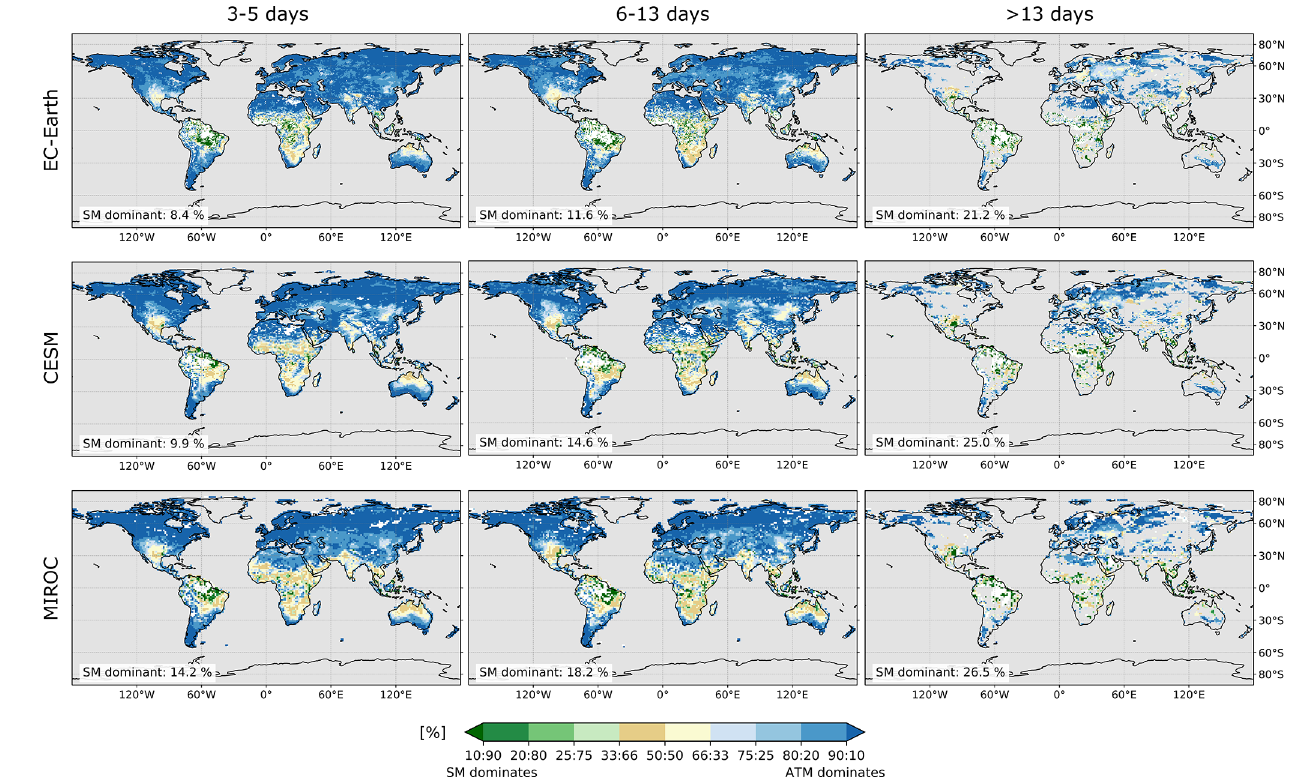
Figure 8. Contribution of atmospheric circulation (ATM) vs. soil moisture (SM) to warm spells during the local summer season when daily mean temperature anomalies exceed 1.5SD (standard deviation) from the ERA-Interim 1981–2010 climatology. The local summer season is defined as the hottest consecutive 3 months (from ERA-Interim) for each grid point. The two approaches to compute the SM vs. ATM contribution are merged, giving equal weight to both. Events are categorized into spells lasting 3–5d, 6–13d, and 14d or longer. Ocean grid points, Antarctica, Greenland, and Iceland are masked out in grey using the Greenland–Iceland (GIC) region from the AR6 reference regions for the latter two. Grid points for which no events were identified are also masked out in grey. Grid points for which the contributions could not be determined (see text) are masked out in white. In the lower left corner the grid points for which the SM contribution dominates over the ATM contribution ( > 50%) are given as an area-weighted percentage with respect to all valid grid